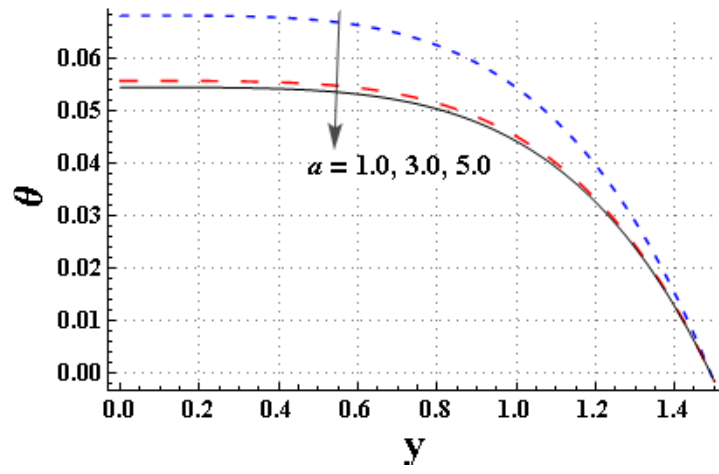
a a , on temperature,  . Figure 12. Effect of non-Newtonian coefficient, a , on temperature, θ , on temperature,  .